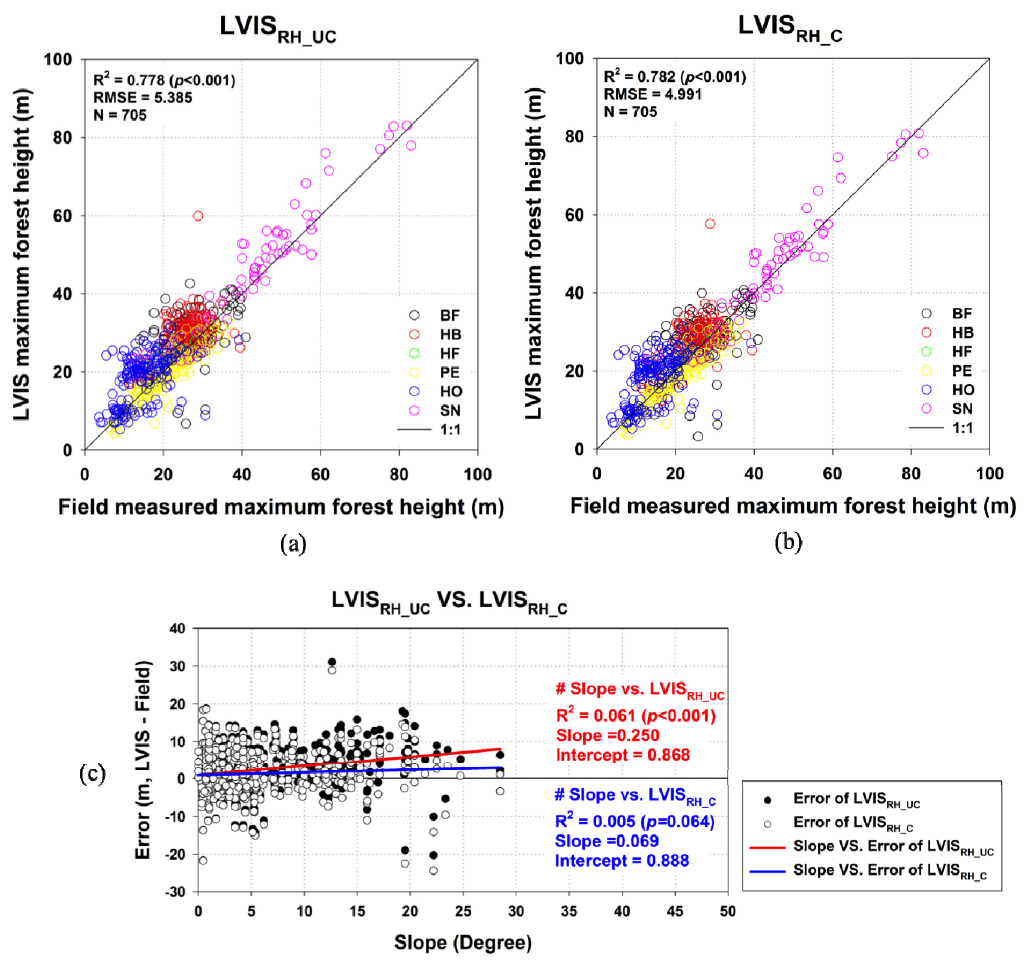
Figure 4. Comparisons of ( a ) uncorrected (LVIS ) and ( b ) corrected (LVIS ) LVIS RH_UC RH_C metrics against field-measured maximum forest canopy heights. Colors correspond to each field site; ( c ) Distribution of LVIS height errors by slope gradients. Filled markers with red fitted line represent errors for LVIS , while unfilled markers with blue fitted line RH_UC correspond to errors for LVIS . RH_C